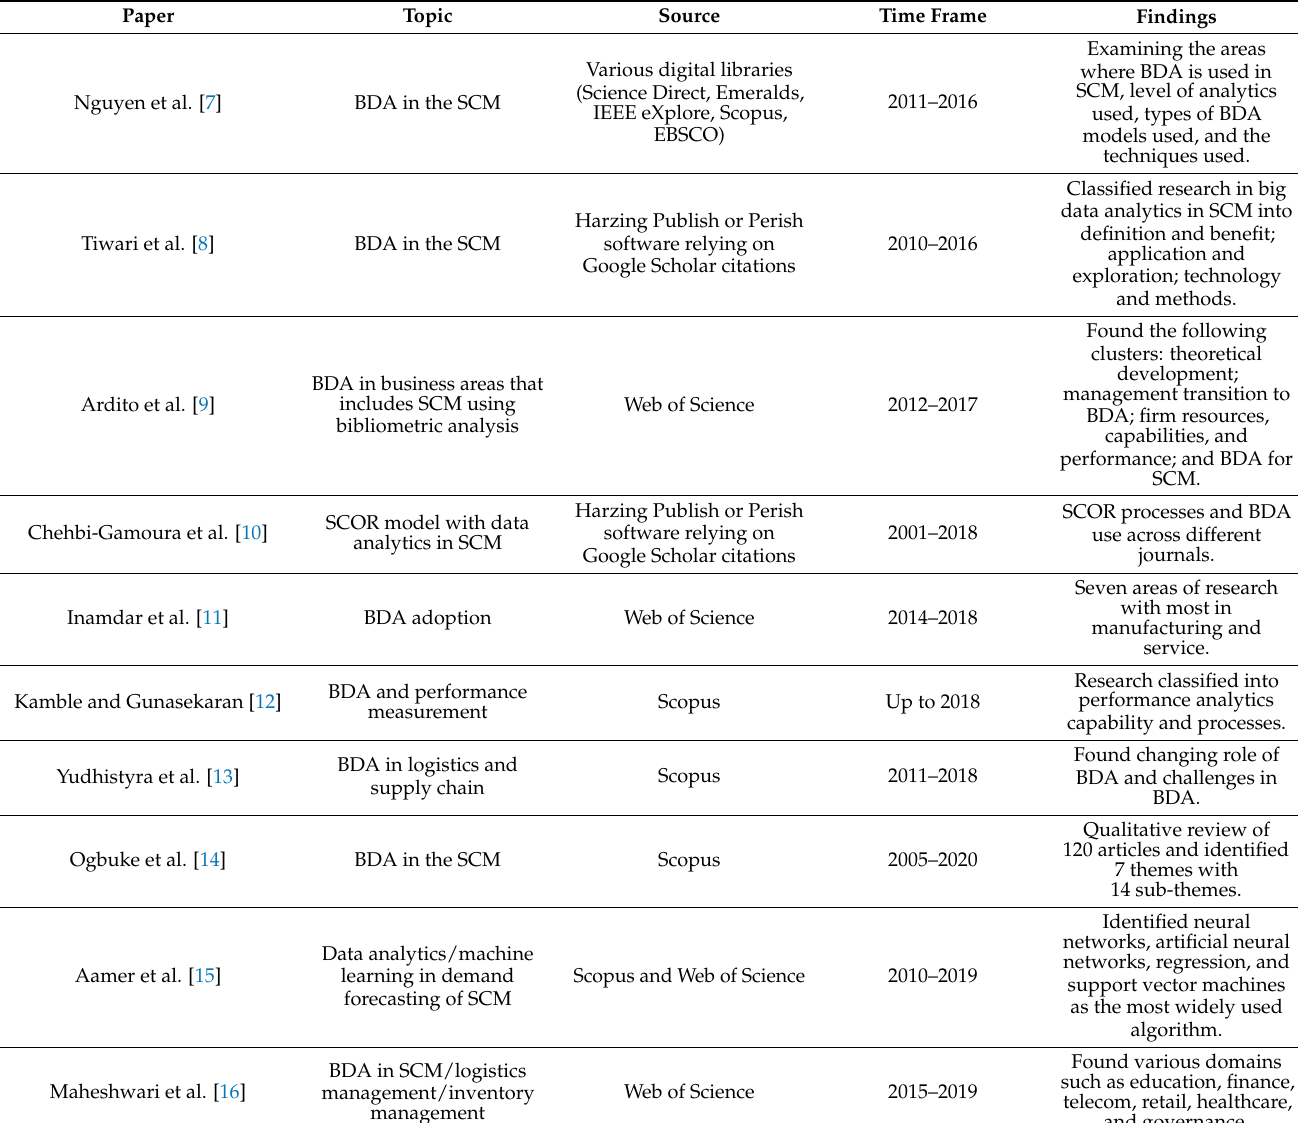
Table 1. Selected literature review articles on data